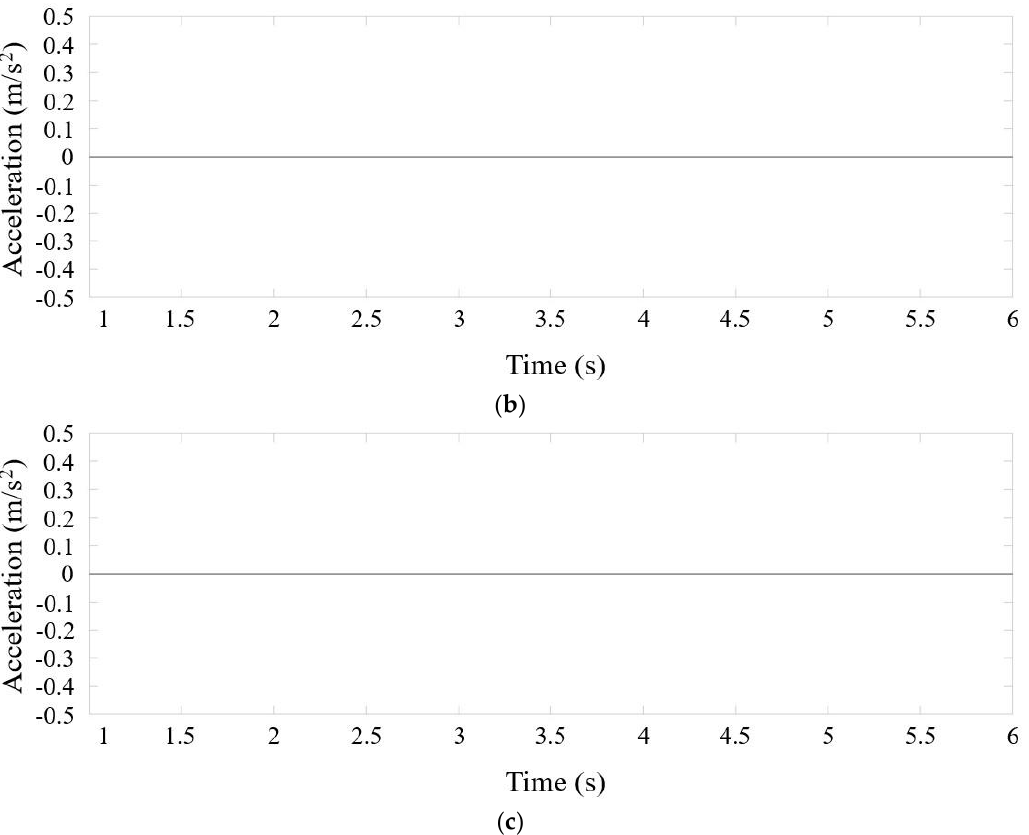
Figure 10. The vertical accelerations of the swing shaft ( a ), the lower die ( b ) and the frame ( c ).